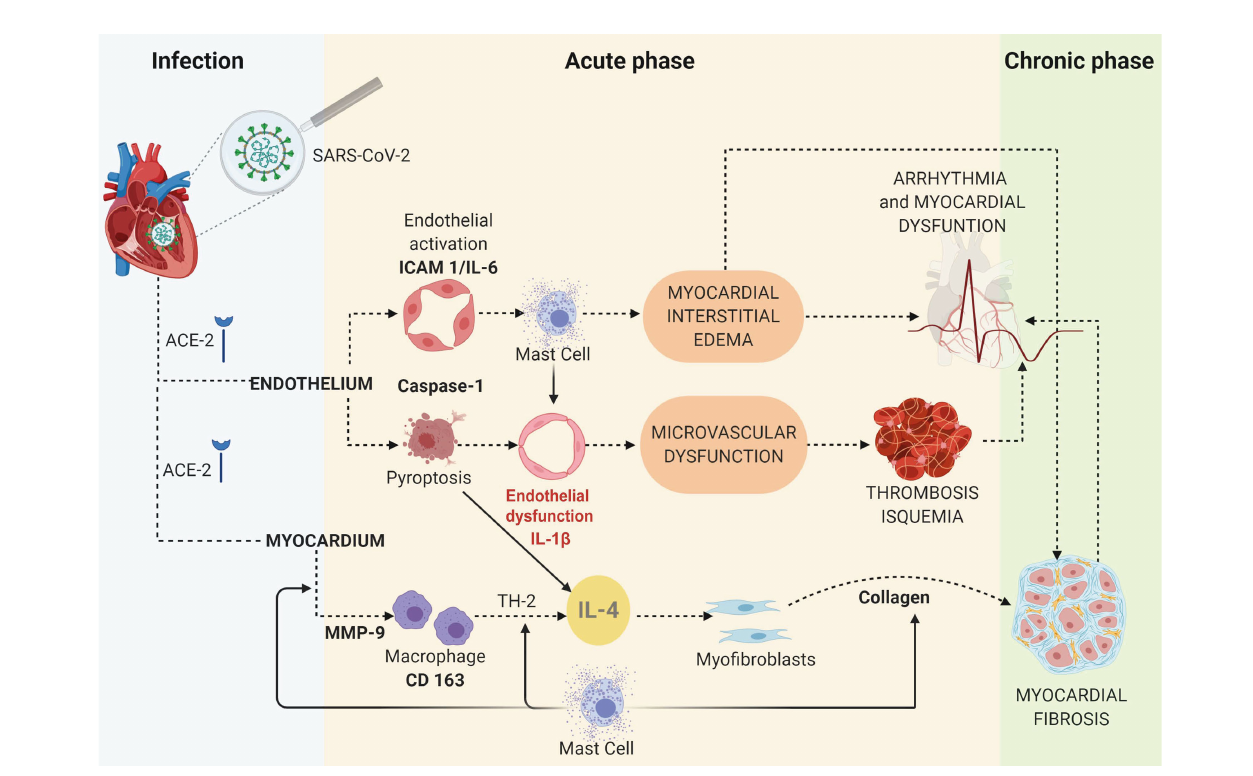
FIGURE 3 | The proposed mechanisms of myocardial injury based on an IHC study of COVID-19 cases and